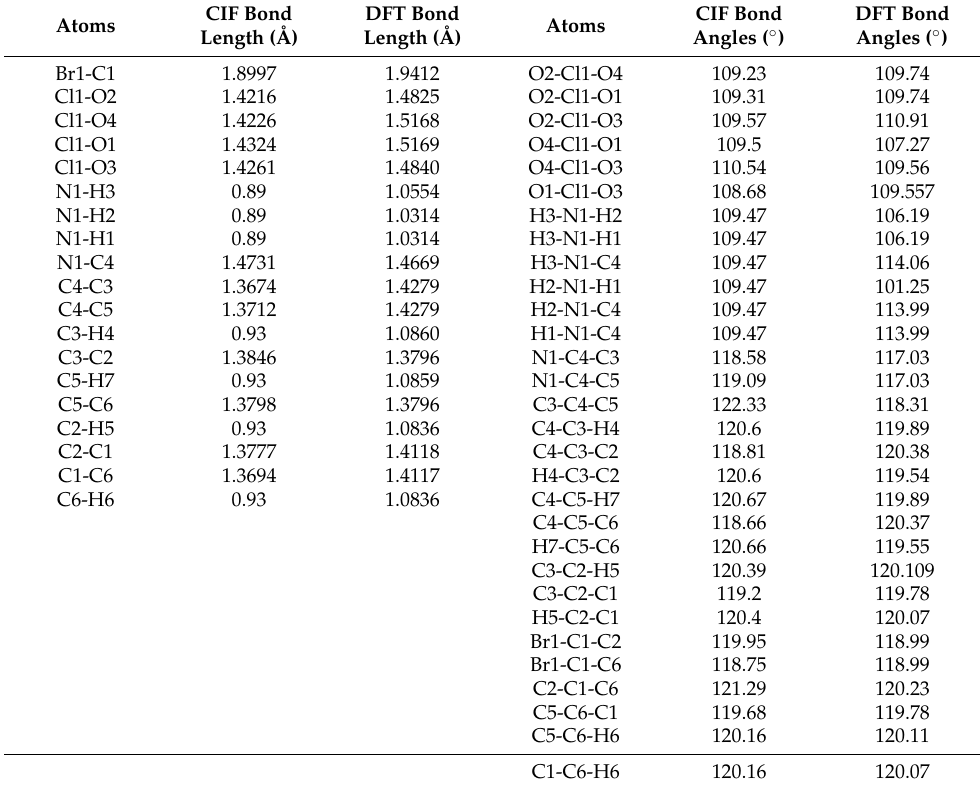
Table 2. Geometrical structural parameters of optimized geometry and single-crystal